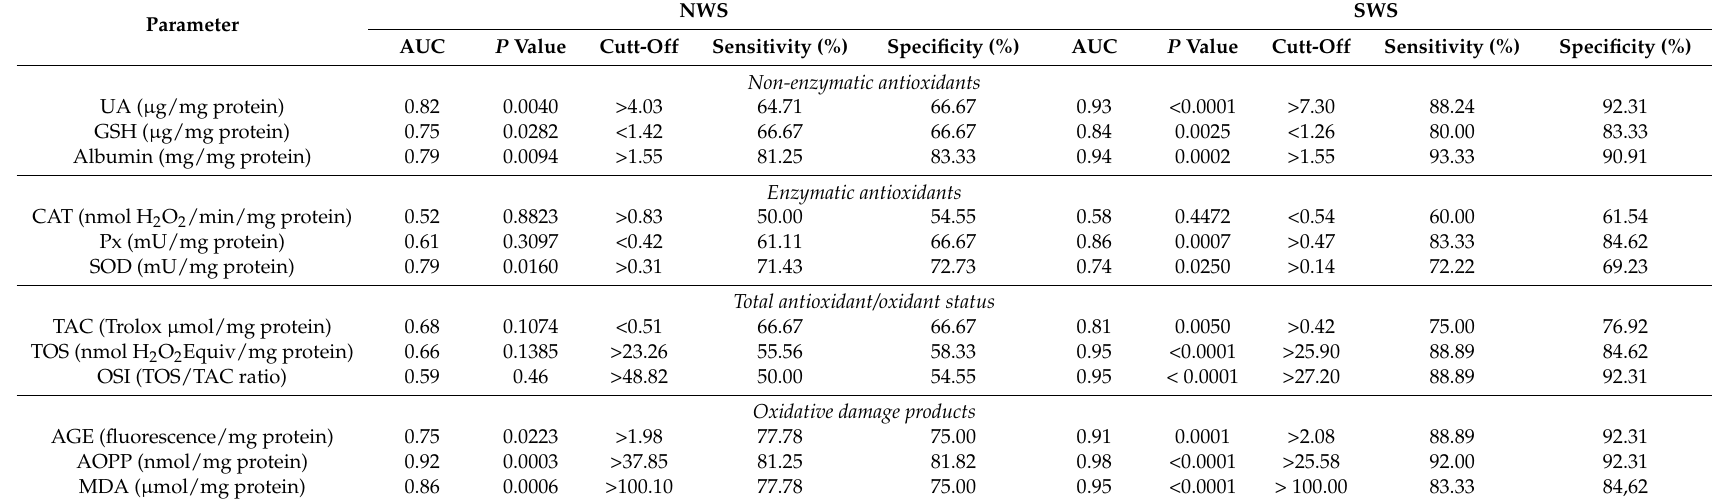
AGE (fluorescence/mg protein)